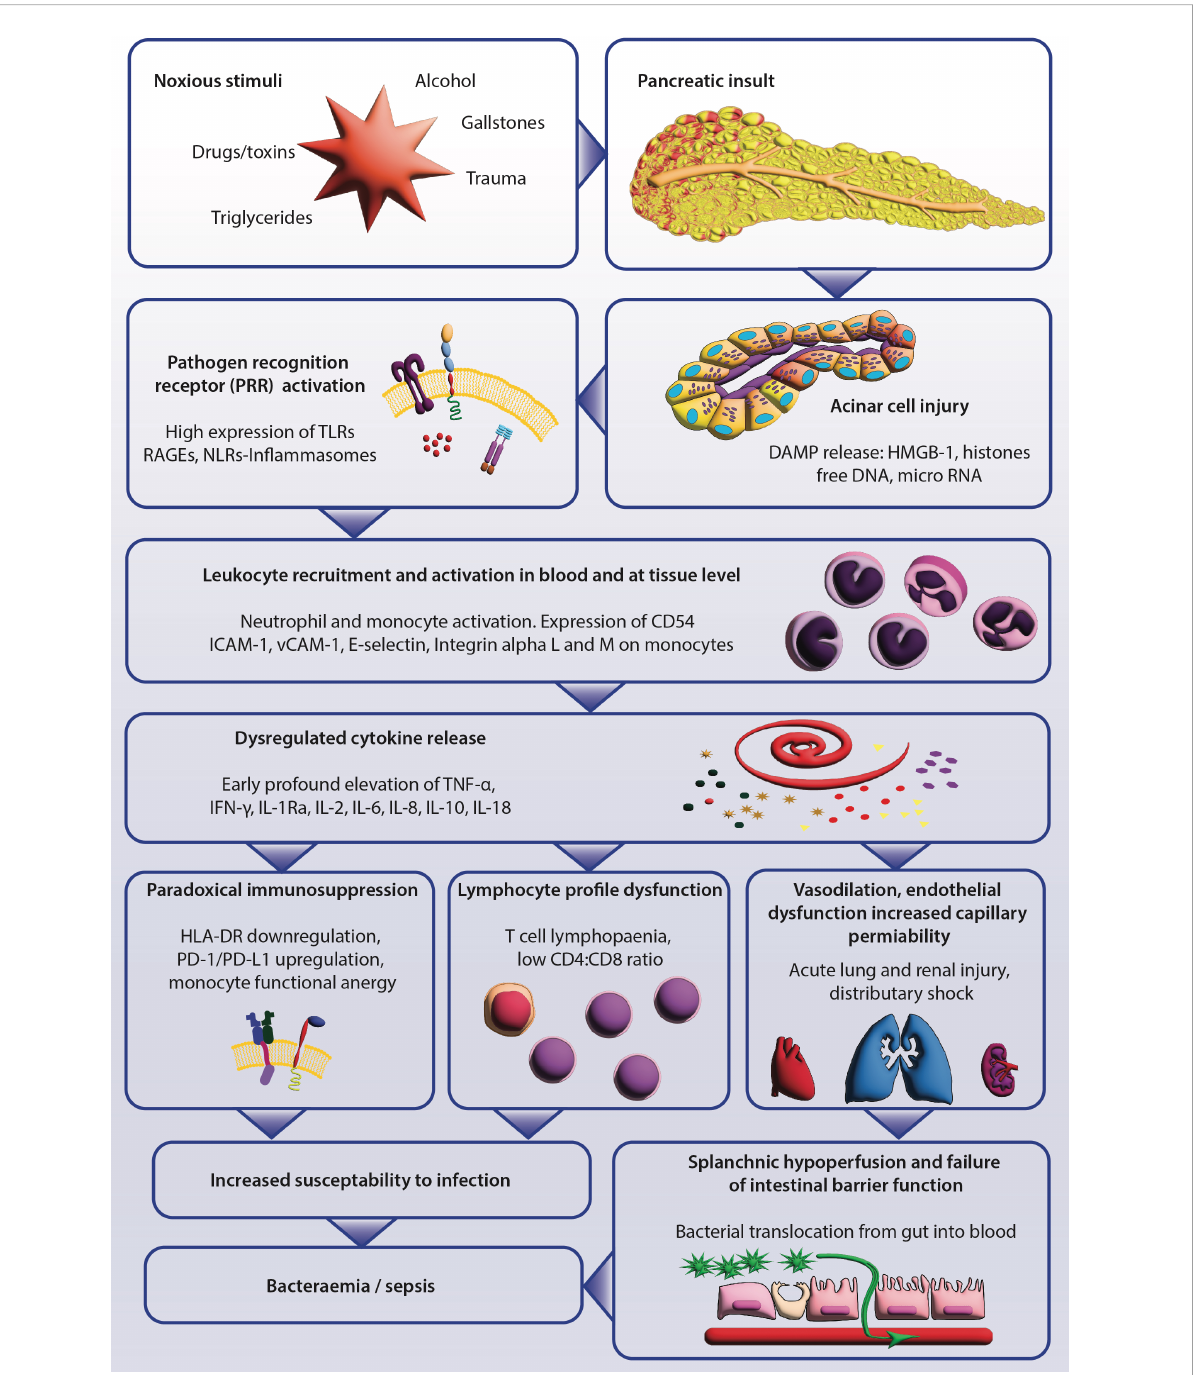
FIGURE 2 Summary of the current understanding of the immunopathogenesis of severe acute pancreatitis (SAP). The initial pancreatic injury can be instigated by a variety of noxious stimuli; acinar cell injury releases damage-associated molecular patterns (DAMPs). DAMPs are recognised by pattern-recognition receptors (PRR), which activate tissue and peripheral blood leukocytes and triggers the in fl ammatory cytokine release. The sequelae include alterations in lymphocyte phenotype, paradoxical hallmarks of immunosuppression, and a systemic in fl ammatory syndrome of endothelial dysfunction. Increased vascular permeability that causes distributory shock and multi-organ failure also occurs. Local and systemic factors induce failure of the intestinal barrier, promoting bacterial translocation. The relative immunode fi ciency and increased intestinal permeability signi fi cantly increase the risk of secondary infectious